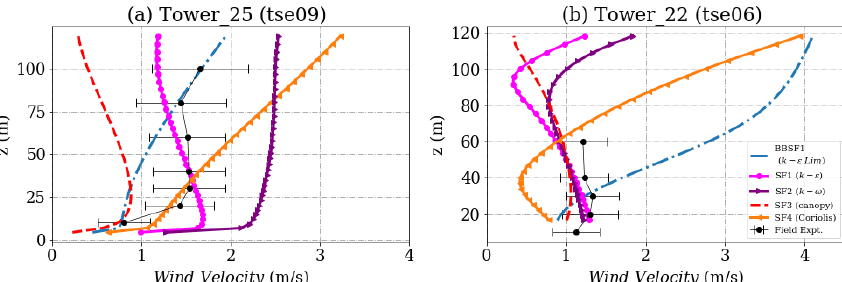
Figure 9. Simulation results and experimental data wind velocity inside the valley for (a) Tower 25 (tse09) and (b) Tower 22 (tse06). The locations of the masts are given in Fig. 2.